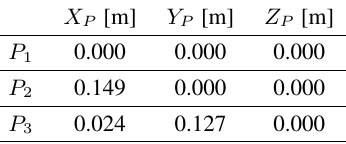
Table 1. Platform coordinates of the three platform points.